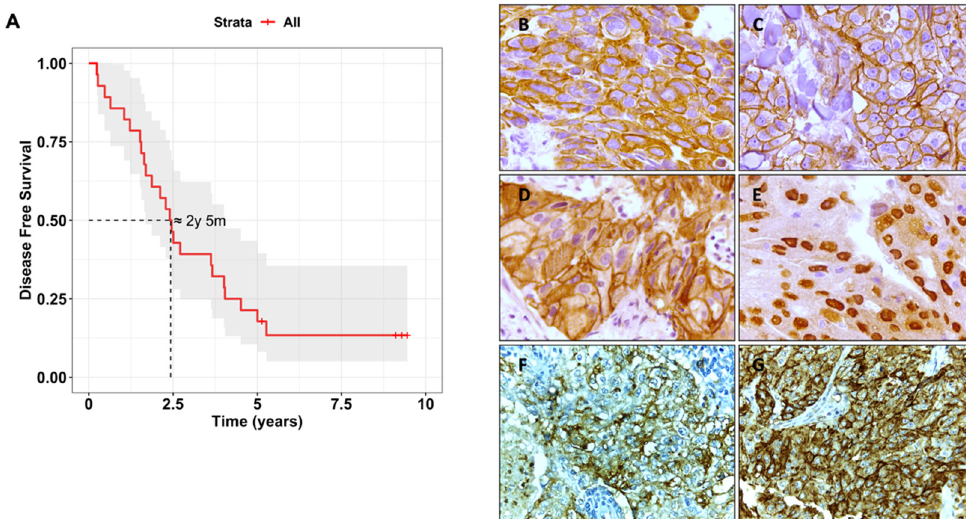
Figure 1. Disease-free survival (DFS) of the triple-negative breast cancer (TNBC) patient cohort and respective immunohistochemical biomarker staining of respective TNBC tissues. ( A ) Kaplan–Meier curve of DFS of all TNBC patients enrolled in this study generated with the survminer (v0.4.9) and survival (v3.4-0) R packages. Representative microphotographs (400X magnification) of immunohistochemical staining against cytokeratin (CK) 5/6 ( B ), P-cadherin ( C ), Epidermal Growth Factor Receptor (EGFR) ( D ), Androgen Receptor (AR) ( E ), Sialyl-Lewis X and A (sLe X/A ) ( F ) and E-selectin ligand (E-SL) ( G ) in TNBC tissue sections. Tissues were stained with hematoxylin, which colours nuclei. The staining with antibodies or E-Ig was followed by a horseradish peroxidase conjugated secondary antibody and visualised in brown. Table 1. Distribution of the expression of the biomarkers in the TNBC population tested in this